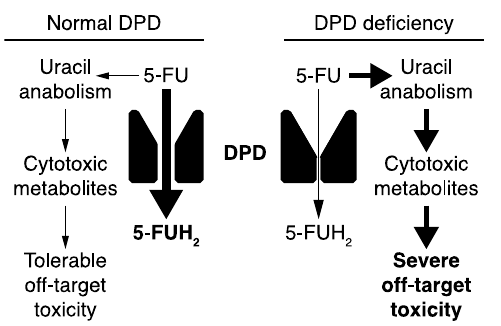
Figure 1. Overview of 5-FU metabolism showing that the catabolic pathway is the dominant pathway unless DPD deficiency causes a shift in 5-FU metabolism toward anabolism, resulting in increased risk for severe treatment-related toxicity.